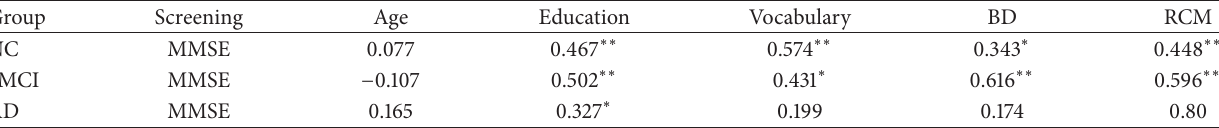
Table 3: Correlations between the MMSE and age, education, and intelligence variables.